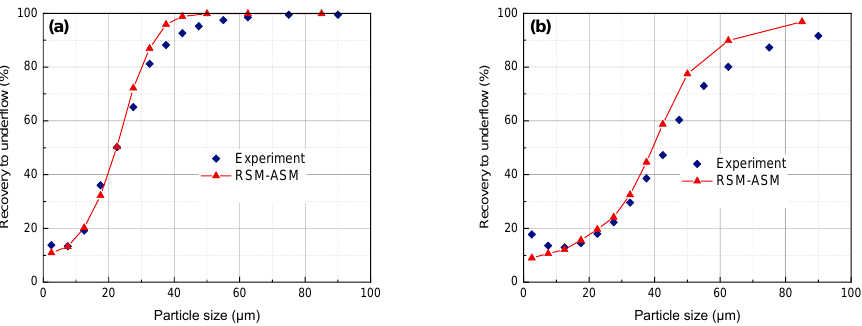
0 020406080100 Figure 8. Comparison of partition curves of Φ 150 mm hydrocyclone. ( a )—Cv = 5%; ( b )—Cv = 15%. Figure 8. Comparison of partition curves of Φ150 mm hydrocyclone. ( a ) — Cv = 5%; ( b ) — Cv = 15%.